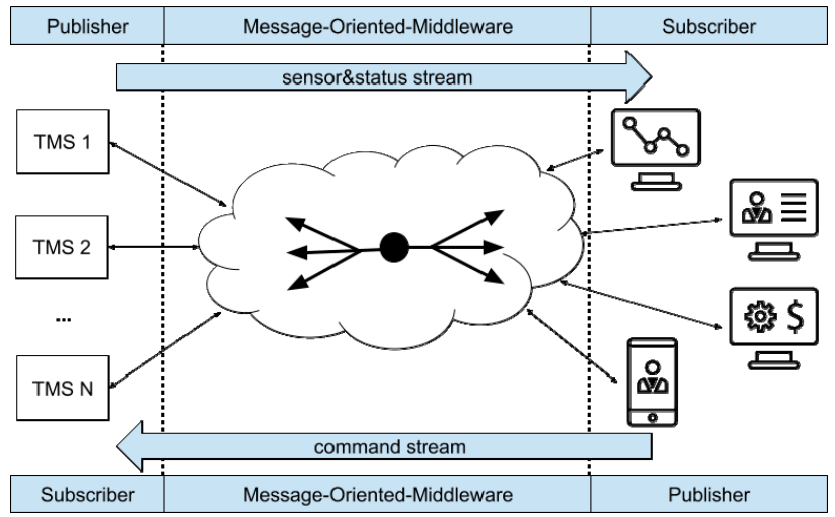
Figure 2. The general problem of data exchange between TMSs and their authorized users.